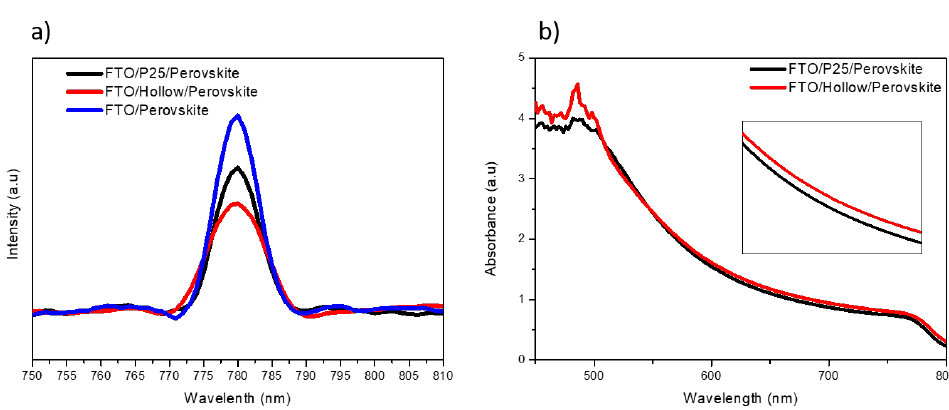
Figure 8. ( a ) PL spectra of the P25 and TiO 2 hollow nanosphere-based perovskite films. ( b ) Absorbance spectra of perovskite deposited on P25 and hollow TiO 2 layers.